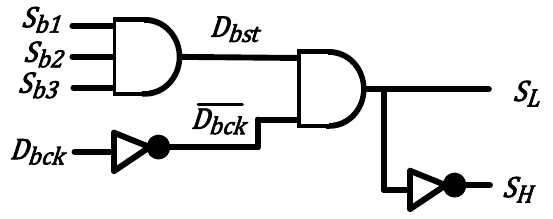
Figure 5. The simplest logic control for higher ( SH ) and lower ( SL ) switches.